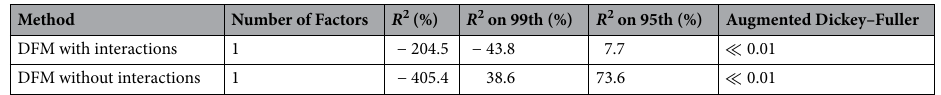
2 Table 3. Results for DFM. R is reported for the full dataset and for the 99th and 95th percentiles. In analogy 2 with the classical R , we compute the RSS term as the squared residuals given after the reconstruction step using only the retained principal components and the TSS term as the total variance contained in the original variables. We also report Augmented Dickey–Fuller test for stationarity of the ESR index. Negative values of R occur because of large reconstruction